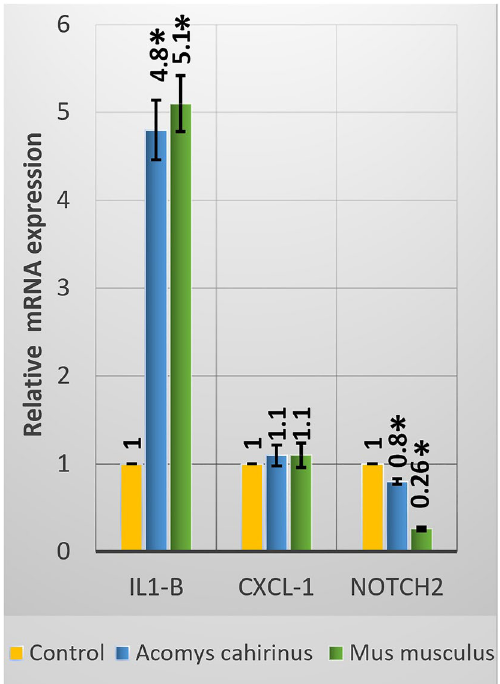
Figure 2. Gene expression analysis of IL1-β , CXCL-1 , and Notch 2 in brain samples of Acomys cahirinus and Mus musculus , following acute administration of LA. Data presented as mean ± standard error of mean. Asterisk: significant ( p < 0.05) difference as compared with the corresponding control